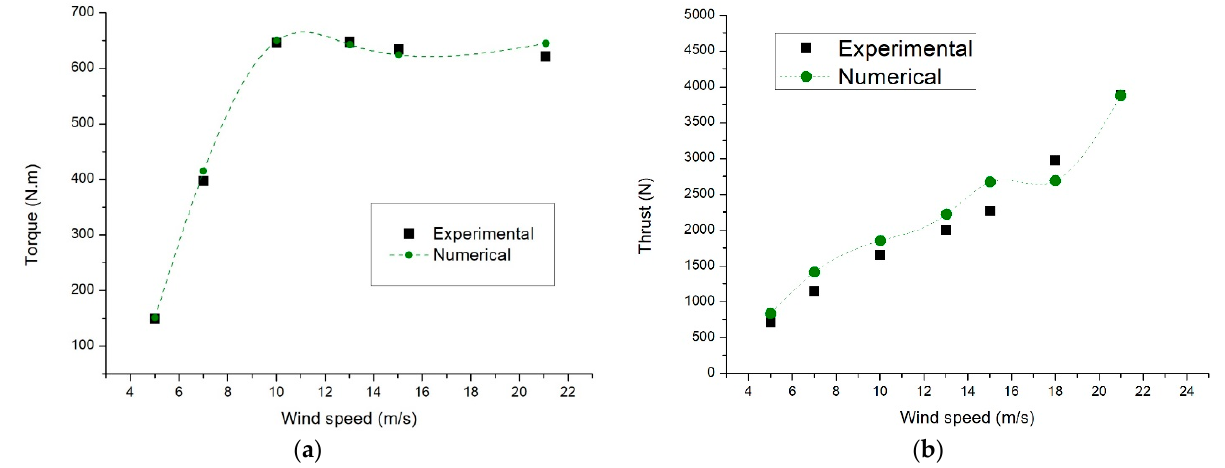
Figure 6. Torque ( a ) and thrust ( b ) comparison with the experimental data [60] .